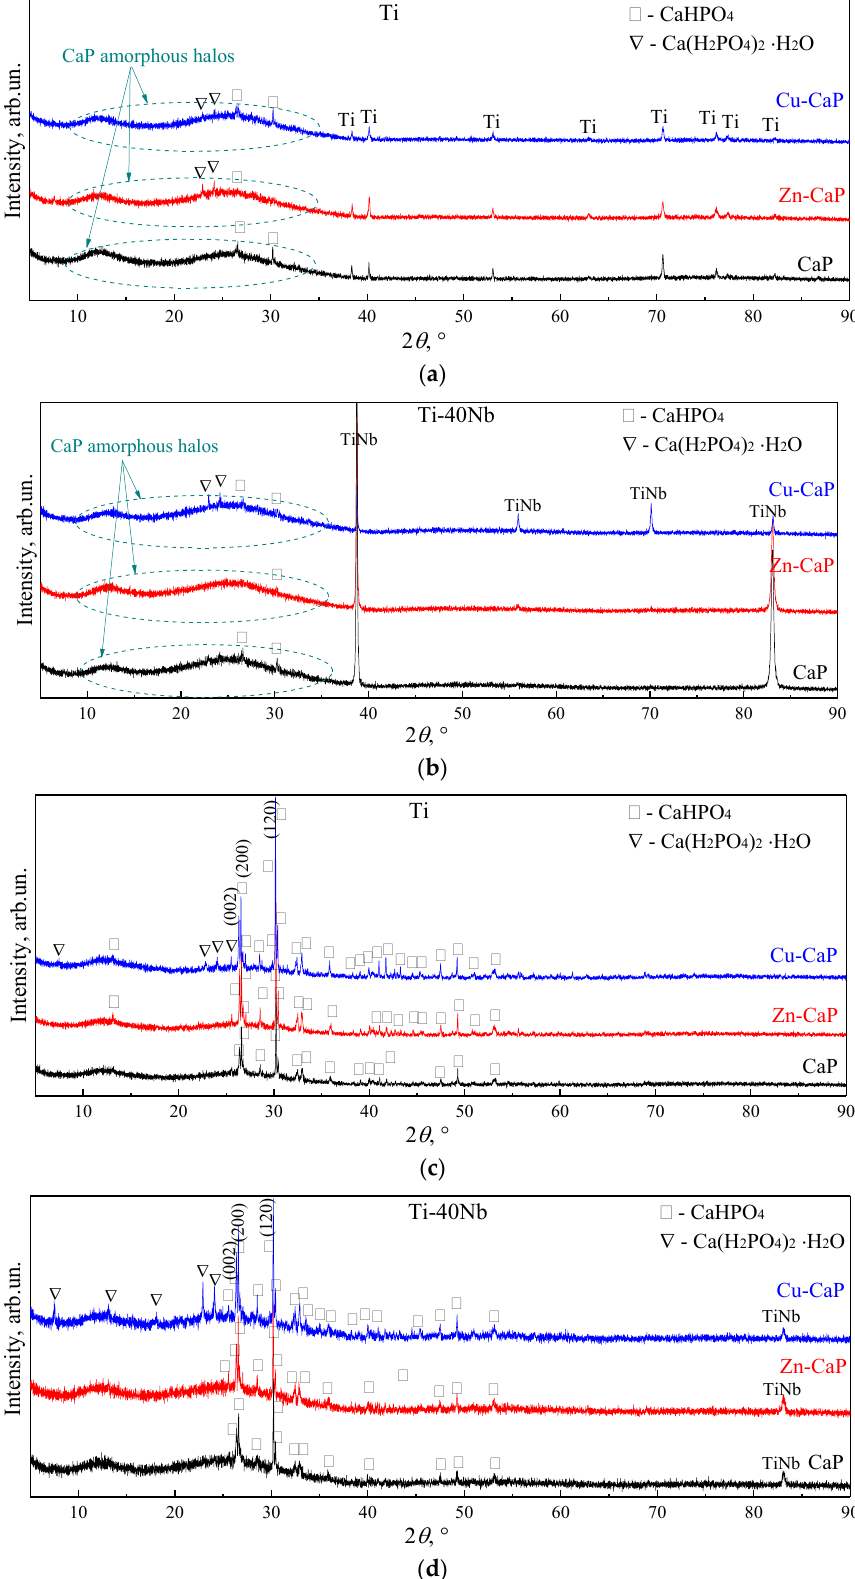
Figure 6. XRD patterns of all the types of coatings deposited at applied voltages of 200 V ( a , b ), 350 V ( c ) and 300 V ( d ) on Ti ( a , c ) and Ti-40Nb ( b , d ) substrates.